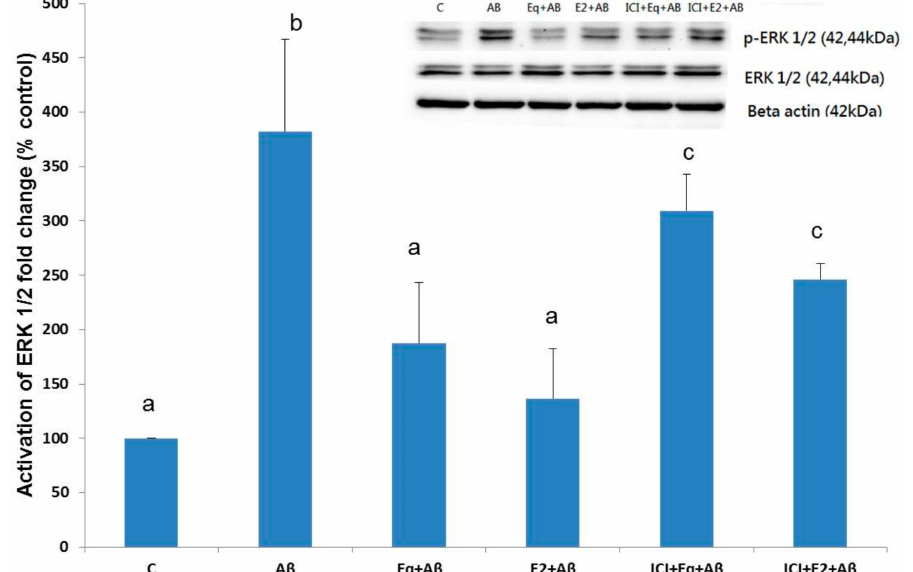
Figure 6. The phosphorylated (activated) ERK 1 / 2 expressions of SH-SH5Y cells from di ff erent treatments. Data were analyzed by a one-way ANOVA followed by the LSD post-hoc test and are representative of three independent experiments ( n = 3). Values are presented as the mean + SD. Bars with di ff erent letters are significantly di ff erent at p <